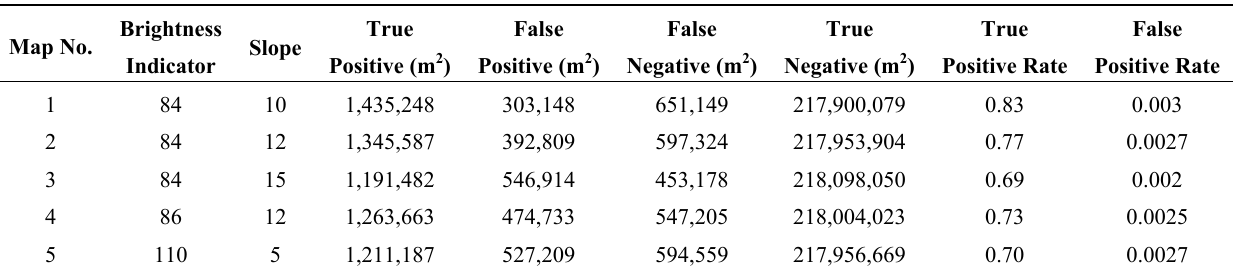
Table 2. Contingency table parameters and rates for different slopes and brightness indicator non-vegetated